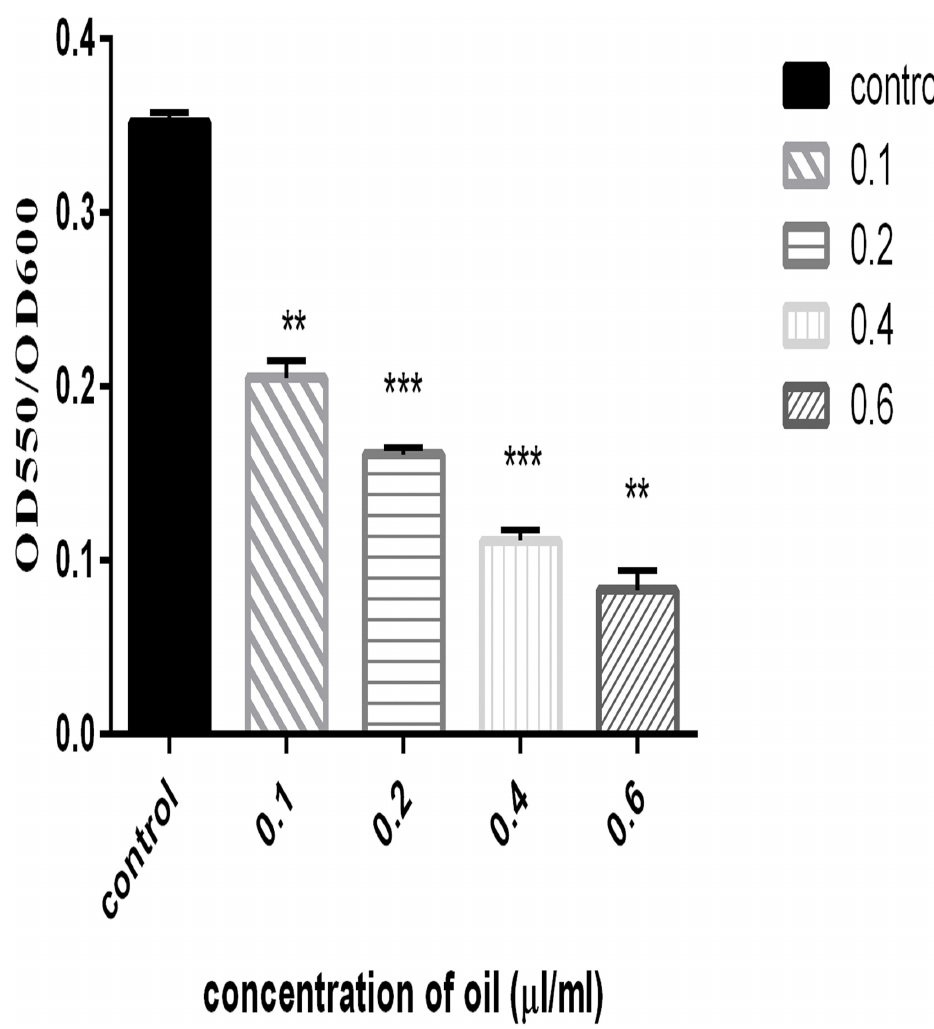
Fig 6. Effect of cinnamon oil on the production of alginate by P . aeruginosa PAO1. Error bars indicate the standard deviation of three measurements, and the data were normalized according to the OD 600 . ** , P < 0.001 compared with the control. *** ,P < 0.0001 compared with the